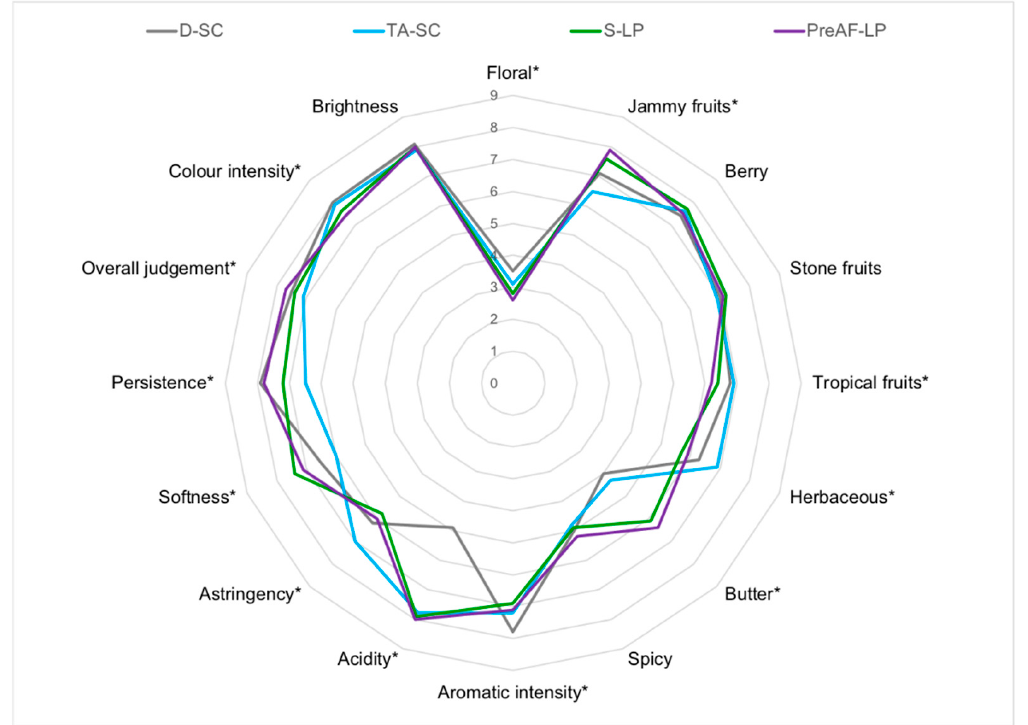
Figure 3. Sensory evaluation of the Cabernet Sauvignon wines obtained from four different fermen- tation modalities. * indicates perception of certain sensory attributes were significantly different be- tween the four batches of wines. Numbers 1–9 indicates the intensity of each sensory attributes.